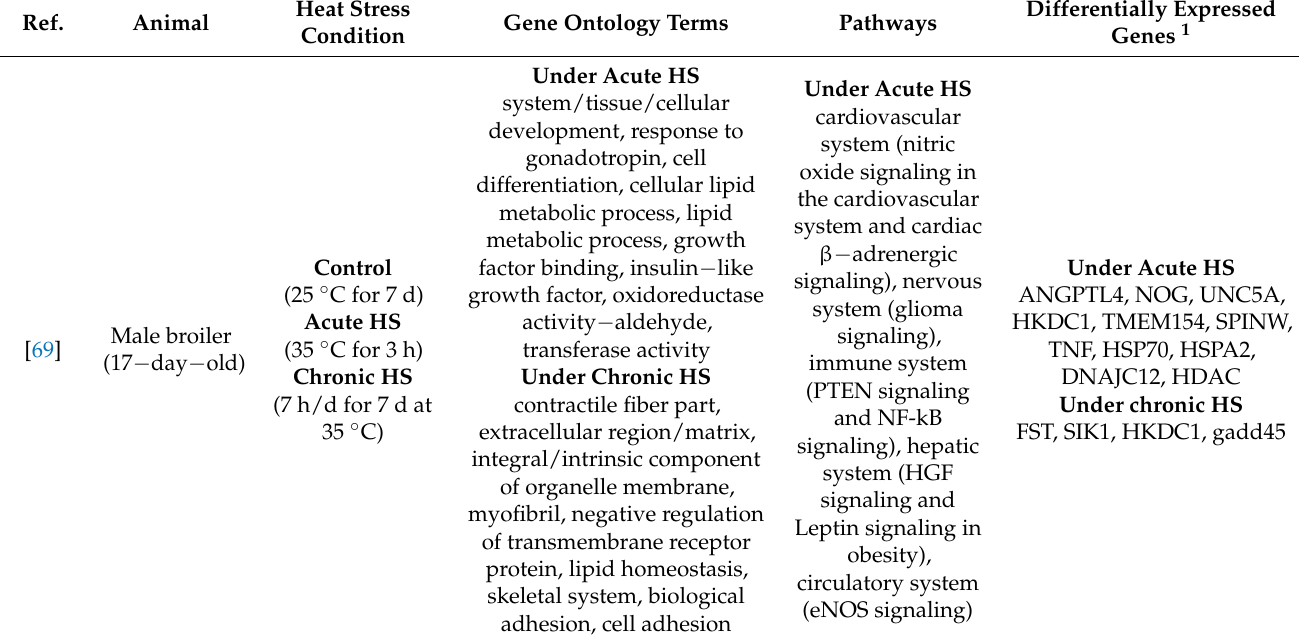
Table 1. Comparisons of liver transcriptomes in chicken exposed to acute or chronic heat stress.